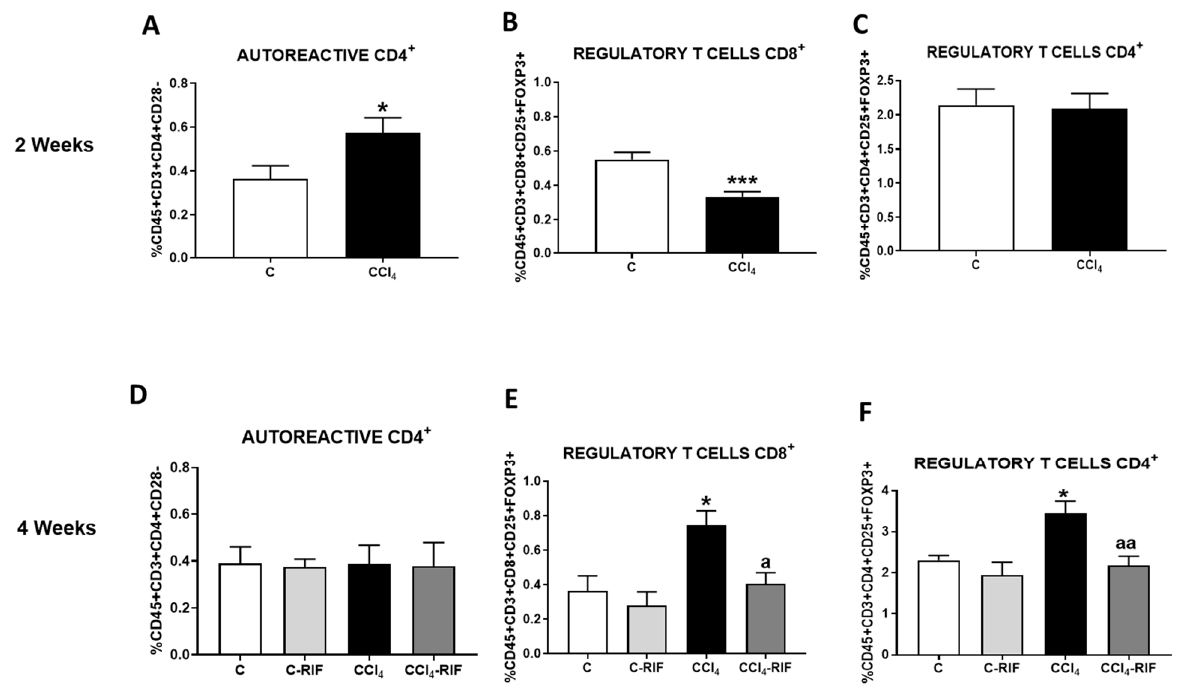
Figure 4. Analysis of autoreactive CD4 + CD28 − and regulatory CD4 + and CD8 + T cells. ( A , D ) Autoreactive CD4 + CD28 − , ( B , E ) regulatory CD8 + T lymphocytes and ( C , F ) regulatory CD4 + T lymphocytes in whole blood at 2 and 4 weeks were analyzed by flow cytometry. Values are mean ± SEM of 8 rats per group. Student’s t -test was used at 2 weeks (t = 2.361, df = 13, p < 0.05 for autoreactive CD4 + , t = 4.297, df = 28, p < 0.001 for regulatory CD8 + ) and one-way ANOVA with Tukey’s test for multiple comparisons at 4 weeks (F(3,24) = 0.0111, p > 0.05 for autoreactive CD4 + , F(3,12) = 6.510, p < 0.01 for regulatory CD8 + and F(3, 15) = 7.61, p < 0.01 for regulatory CD4 + T cells). Values significantly different from control rats are indicated by asterisks and from CCl 4 rats are indicated by a. * p < 0.05; *** p < 0.001; a p < 0.05; aa p < 0.01.